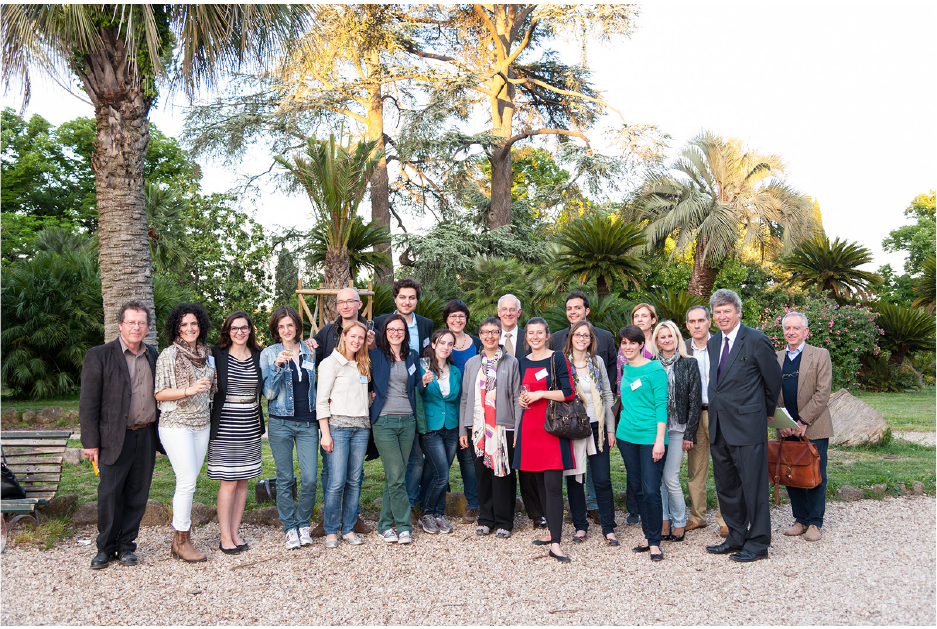
Fig. 2: Anna Paterlini (in red) with professors and participants of the masterclass ‘Turning Charlemagne into an asset for Rome’, The American University of Rome, 5–9 May 2014. (Photo A.